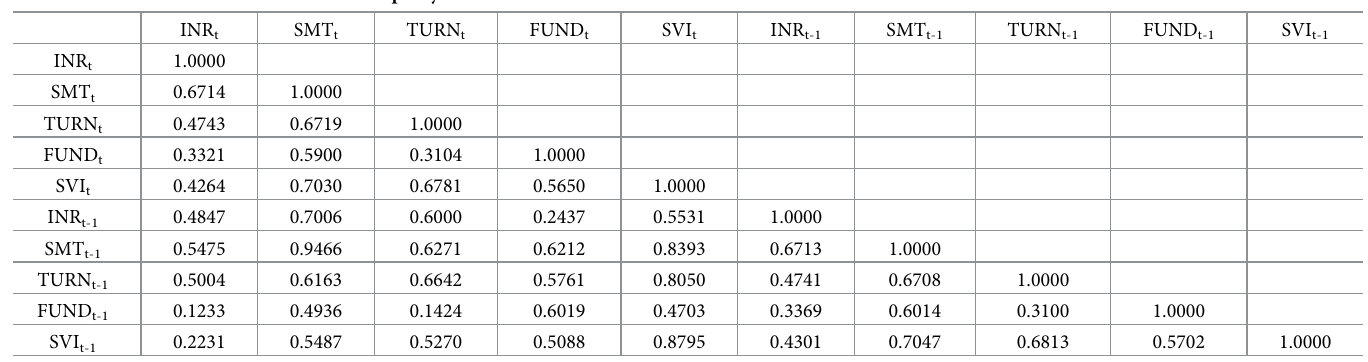
Table 1. The correlation coefficients between proxy variables.